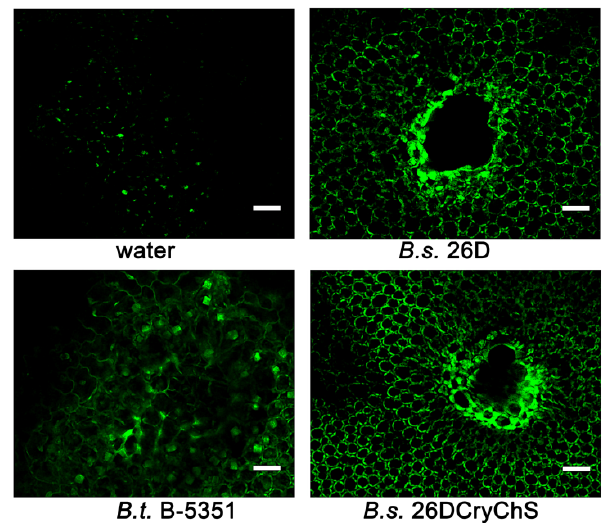
Figure 5. Lignin fluorescence in P. infestans -penetrated sites on leaves of water- and Bacillus sp.-treated potato plants. Scale bars 20 µ m.